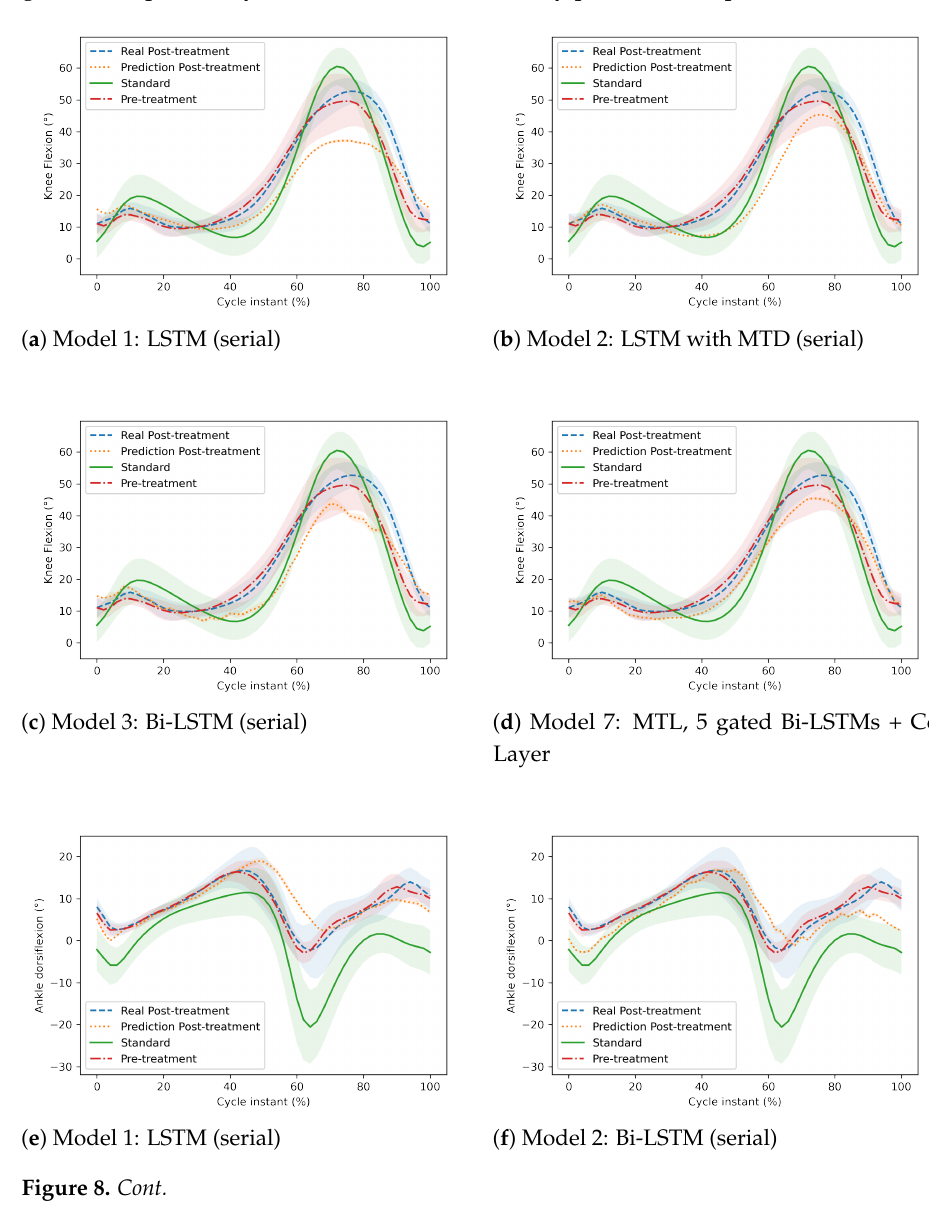
post-treatment trajectories were closer to the real post-treatment trajectories. Last four Figure 9e–h compare the trajectories of the ankle joint. Figure 9e–g represent the prediction of Model 1, Model 2, and Model 3. Although Model 3 is not an MTL model, its predictions were much better than the first two serial models. However, the prediction of the MTL model (Model 5) in Figure 9h was better than all other models for this particular patient. In general, as proven by Tables 4–6, for almost every patient, MTL performed better.